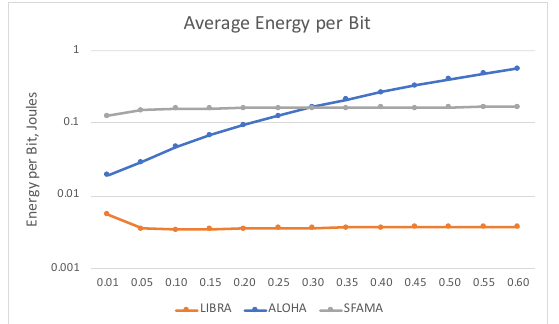
Figure 13. Energy per bit in traffic scenario, in Joules.